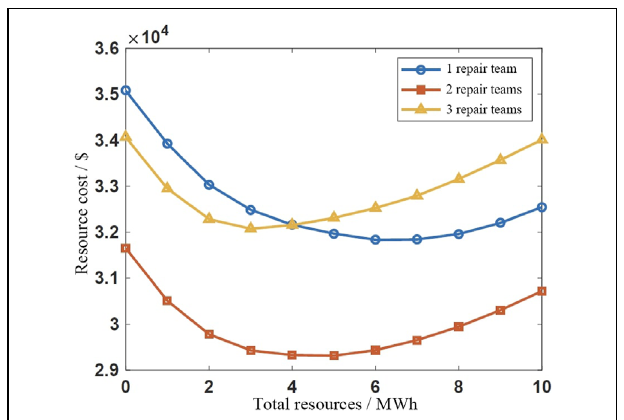
FIGURE 12 | Total resource acquisition cost.